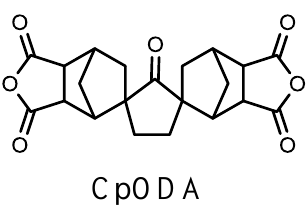
Figure 15. The structure of cycloaliphatic tetracarboxylic dianhydride with cyclopentanone bis-spironorbornane structure (CpODA) [77].